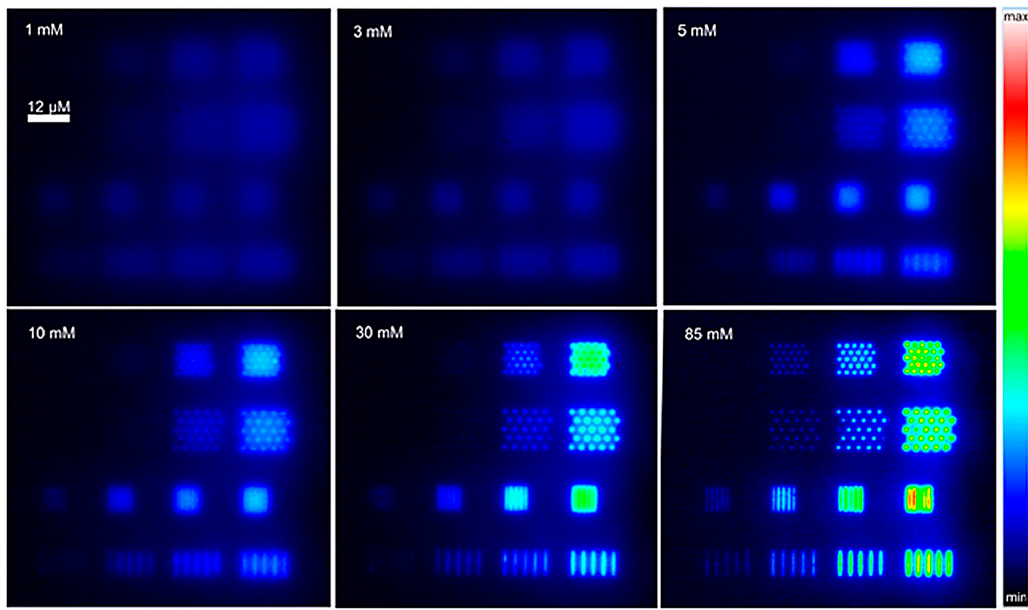
Figure 10. ECL images of a BDD-NEA obtained in phosphate buffer (pH 7.4) containing 1 mM Ru(bpy) 32+ and increasing concentrations of TPrA (indicated in top-left corner of each box). Images were recorded in the dark with a × 50 objective when applying a constant potential of 1.2 V vs. Ag/AgCl/KCl. All images were coded according to the same false colour scale (right) (reprinted with permission from [88]).